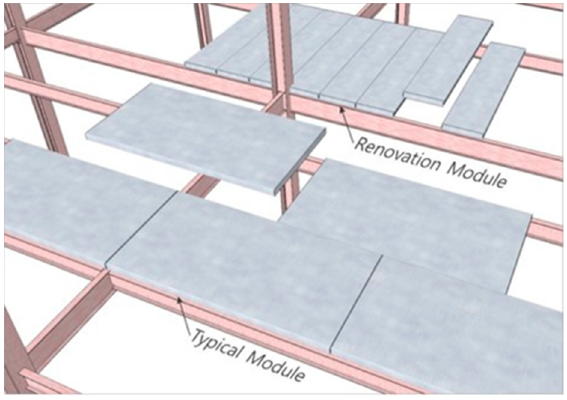
Figure 2. Typical and renovation module.